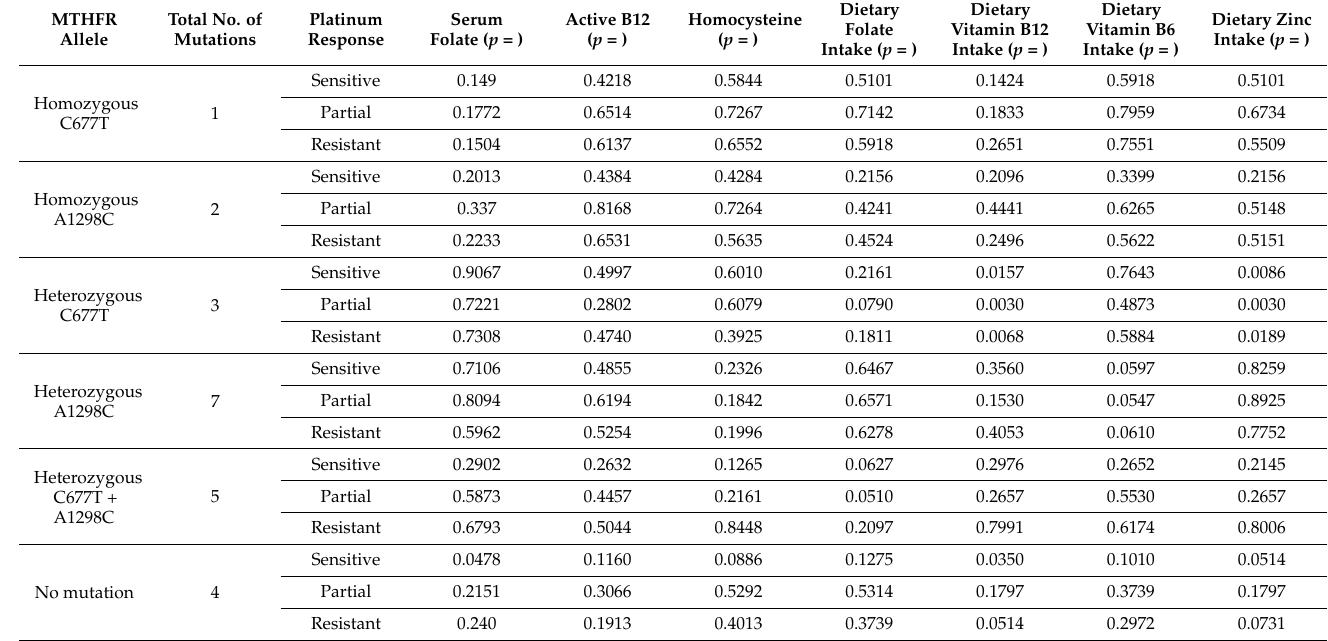
Table 7. MTHFR mutation, platinum response, pathology and dietary intakes: multinomial logistic regression (prob >chi2) analysing the association between MTHFR mutations, platinum sensitivity and blood pathology results and dietary